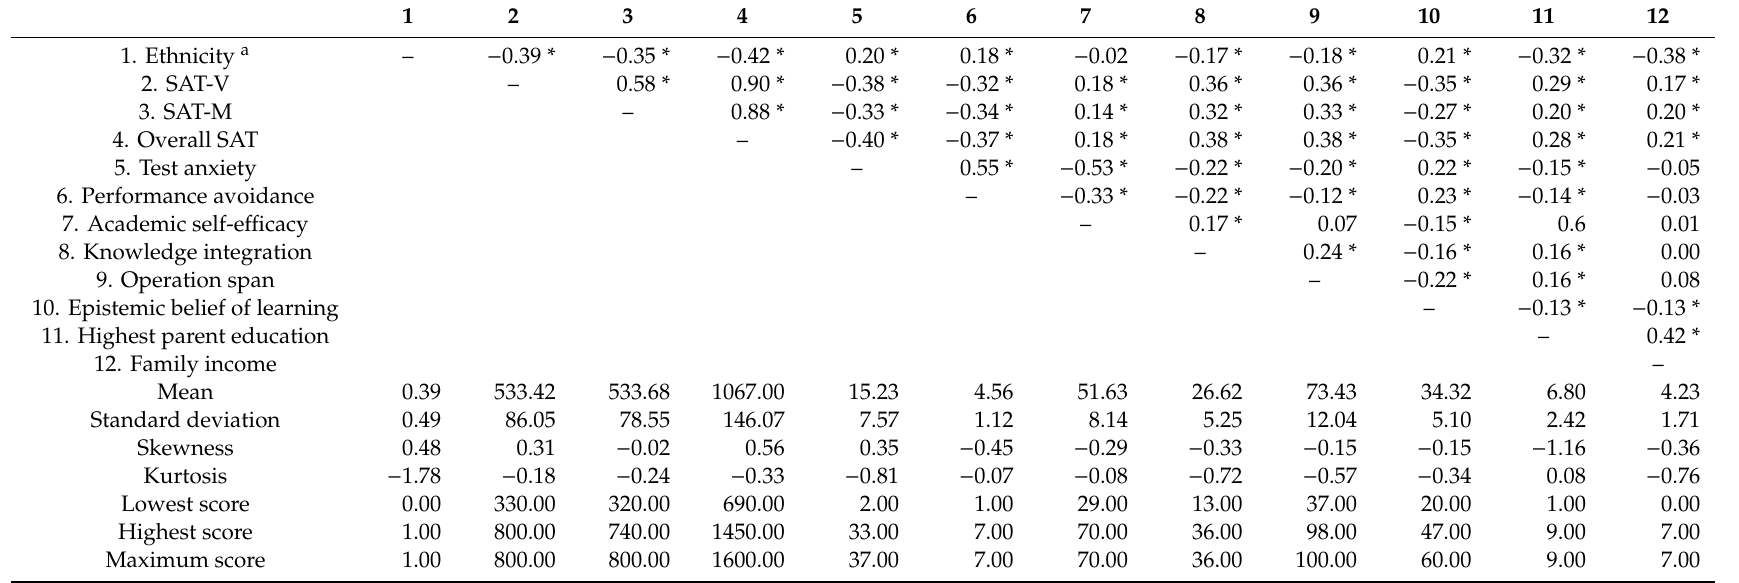
Table 1. Correlations and Descriptive Statistics among Ethnicity, and the Measures of Academic Achievement (i.e., SAT-V, SAT-M, and SAT), Test Anxiety, Performance Avoidance, Academic Self-e ffi cacy, Highest Parent Education, Family Income, and Metacognitive Awareness (i.e., Epistemic Belief of Learning) ( n =